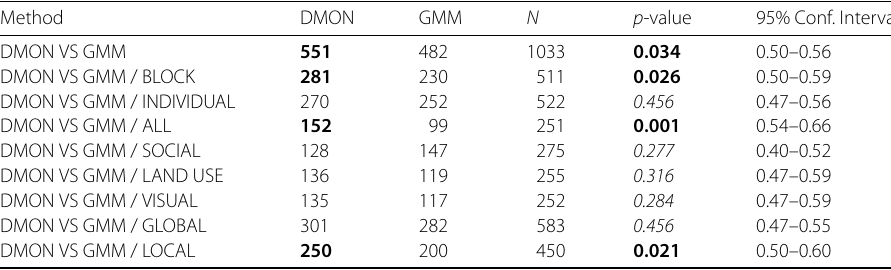
Table 4 Results obtained for method from the survey ∗